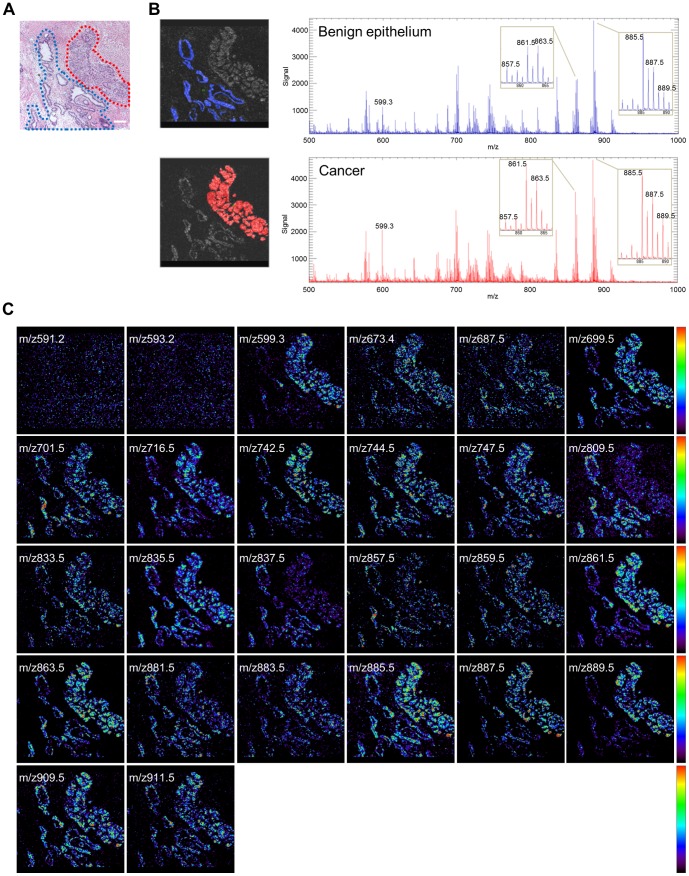
Direct tissue mass spectrometric analysis of human prostate tissue (Case 1).Matrix coated tissue was assessed by negative ion mode HR-MALDI-IMS in the mass range of m/z 500–1000. A, H&E stained human prostate tissue specimen containing defined areas of benign epithelium (blue) and prostate cancer (red). The scale bar represents 200 µm. B, Regions of interest and resulting averaged masses of benign epithelium (upper panel) and prostate cancer (lower panel). The x- and y-axes shows m/z and the signal intensity normalized to total ion current, respectively. C, Mass spectrometry image showing the distribution of 26 common m/z species.